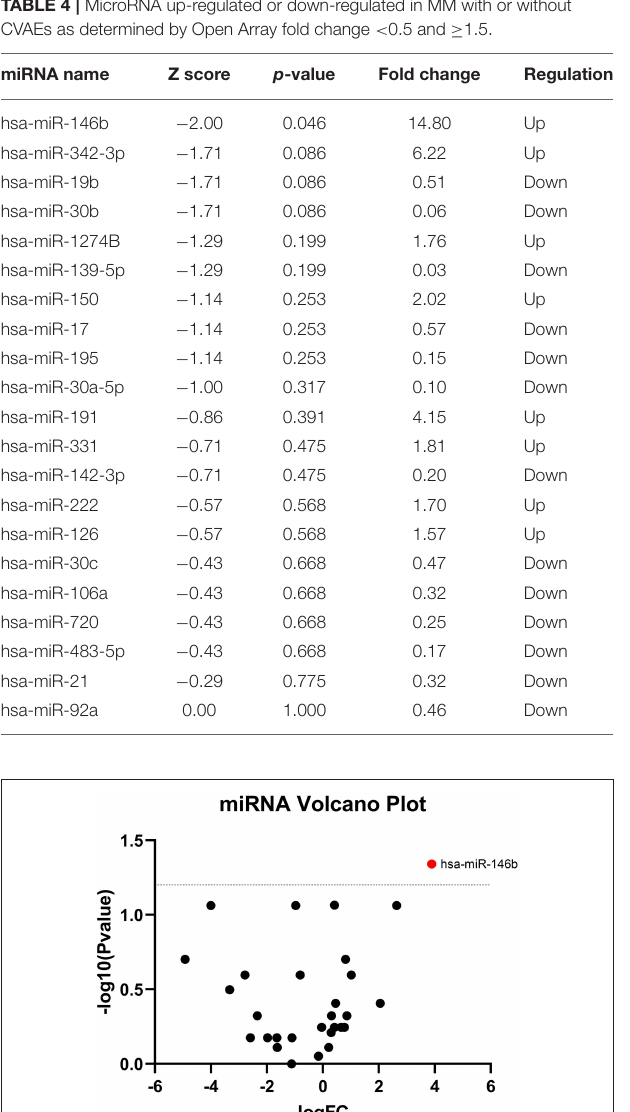
Figure 5 . A lower level of pyruvate and a higher level of lactate in patients with CVAEs are consistent with cardiomyocytes switching substrate preference from fatty acids to glucose because of mitochondrial